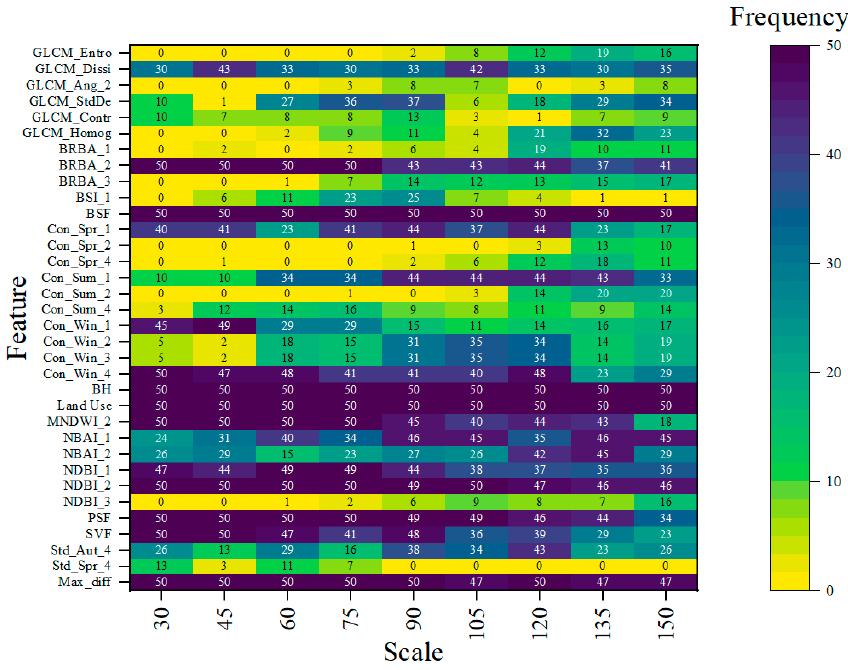
Figure 11. Results of feature selection from scales 30 to 150 with 50 runs at each scale. All results were obtained through CFS. “1”, “2”, “3”, “4” represent blue, green, red, nir, respectively. “Con” represents the convolutional layer, “Std” represents the standard deviation layer, and the abbreviations for the four seasons are “Spr”, “Sum”, “Aut”, “Win”. Features with a total frequency of fewer than 20 times were not considered.